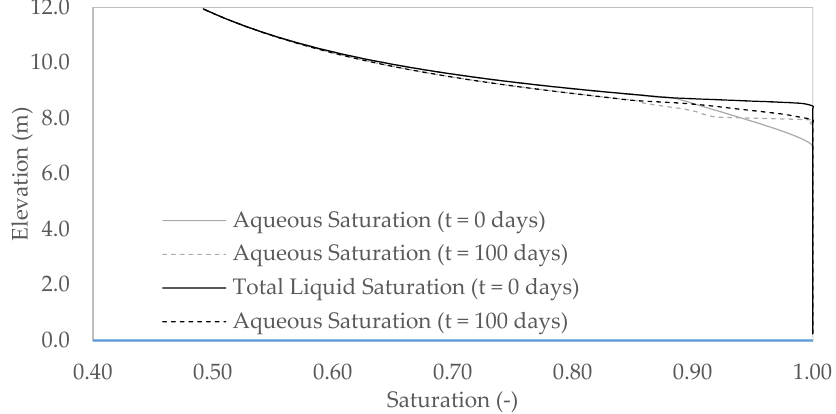
Figure 8. Aqueous and total saturation variation (initial and final) in TE2 under 24.93 kPa for oxisol.